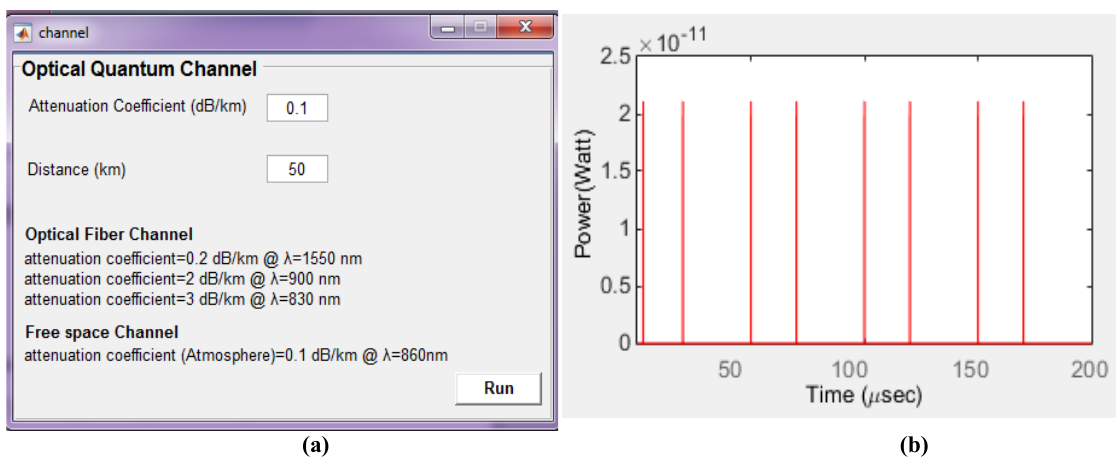
Fig. 9. Test 4 (a) GUI set up (b) result for FS quantum channel for L =50km.